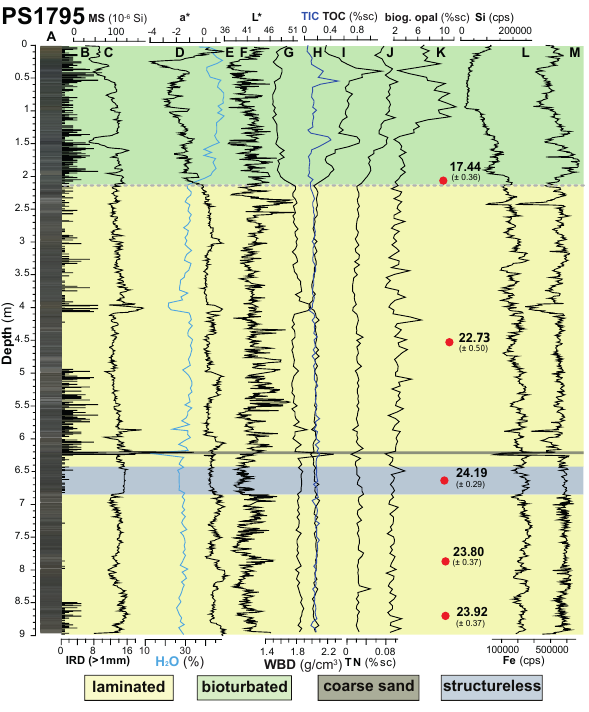
Fig. 2. Sediment-physical data from sediment core PS1795: A shows the red/green/blue 2 Figure 2. Sediment physical data from sediment core PS1795: A (RGB) colour pattern; B shows the amounts of grains >1 mm, representing ice-rafted debris 3 shows the red/green/blue (RGB) colour pattern; B shows the amounts of grains > 1mm, representing ice-rafted debris (IRD; (IRD; method see Grobe (1987)); C is magnetic susceptibility (MS) record; D is colour a* 4 method see Grobe, 1987); C is magnetic susceptibility (MS) record; (green-red component); E shows the water content of the sediment; F gives lightness (L*); G 5 D is colour a* (green-red component); E shows the water con- is wet-bulk density (WBD); H to K are sea-salt corrected (sc) total organic and inorganic 6 tent of the sediment; F gives lightness (L*); G is wet-bulk density carbon (TIC/TOC), biogenic opal, and total Nitrogen (TN); L and M show chemical elements 7 (WBD); H to K are sea-salt-corrected (sc) total organic and inor- Silicon (Si), and Iron (Fe) determined with a X-ray fluorescence-scanner. AMS 14 C ages 8 ganic carbon (TIC/TOC), biogenic opal, and total nitrogen (TN); (marked with red dots) measured on planktonic foraminifera Neogloboquadrina pachyderma 9 L and M show chemical elements silicon (Si), and iron (Fe) deter- mined with an X-ray fluorescence scanner. AMS 14 C ages (marked are given in ka cal before present. The grey line at 2.15 m depth marks a possible hiatus (see 10 with red dots) measured on planktonic foraminifera Neogloboquad- section 4.2). 11 rina pachyderma are given in ka cal before present. The grey line at 2.15m depth marks a possible hiatus (see Sect. 4.2).